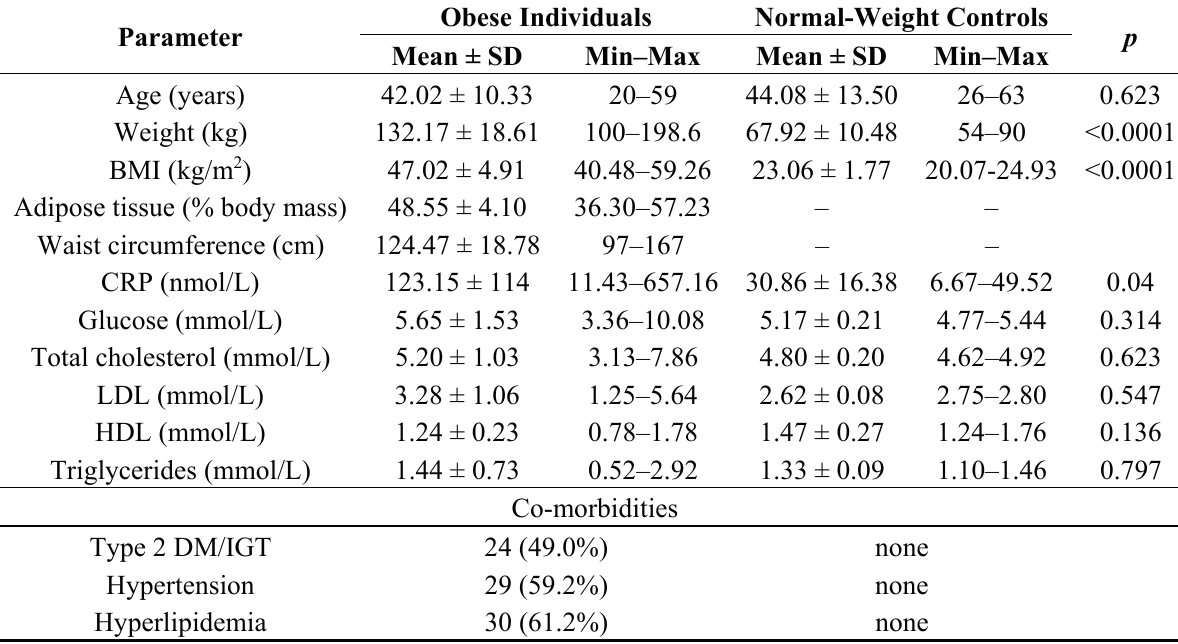
Table 1. Selected clinical and biochemical parameters of study